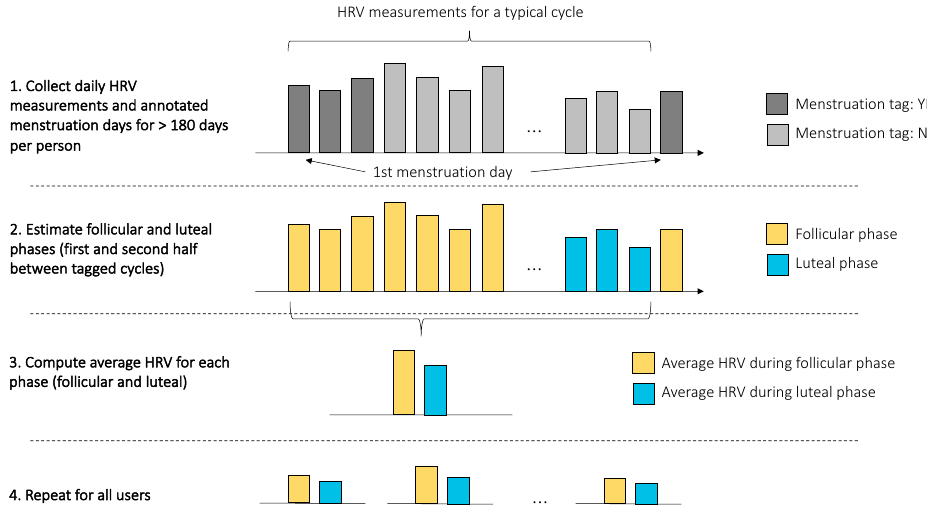
Figure 3. The procedure used for the analysis of the menstrual cycle. First, HRV (and resting heart rate) data, and annotated menstruation days were collected. Then, the beginning of each cycle was defined as the first menstruation day, and the following days, up to the next cycle, were split into two to estimate the follicular and luteal phases. Average heart rate and HRV were computed for each phase (follicular and luteal) and for each